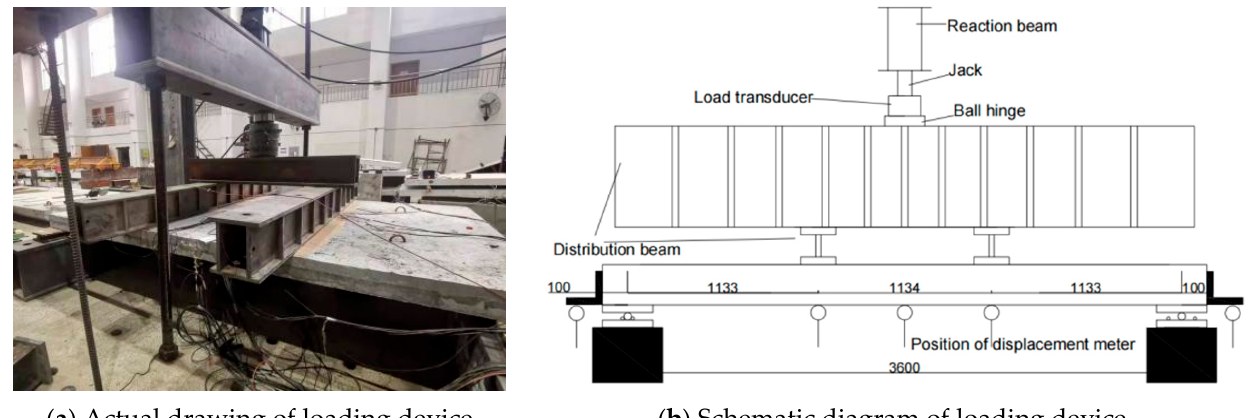
Figure 7. Schematic diagram of test device and loading (unit: mm).